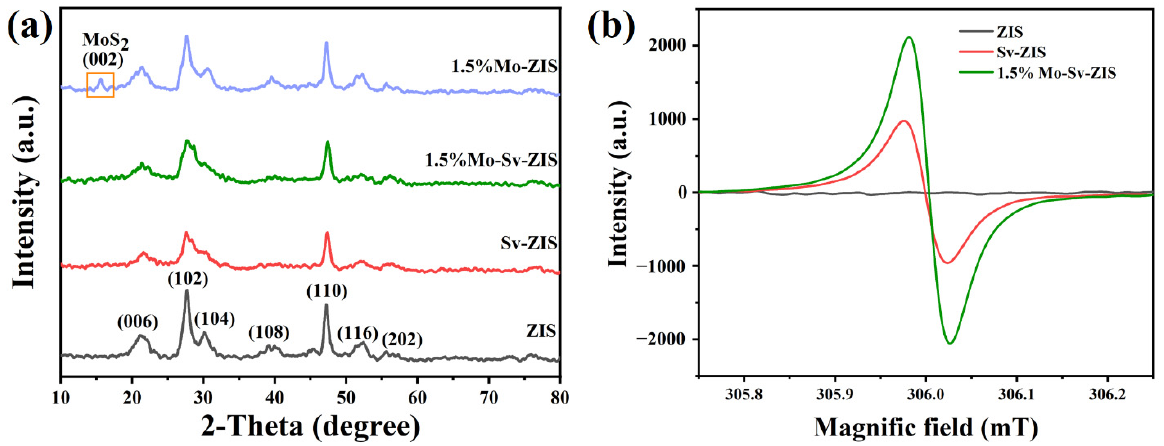
Figure 4. ( a ) XRD patterns of ZIS, Sv-ZIS, 1.5% Mo-ZIS and 1.5% Mo-Sv-ZIS. ( b ) The EPR Spectra of ZIS, Sv-ZIS and 1.5% Mo-Sv-ZIS.